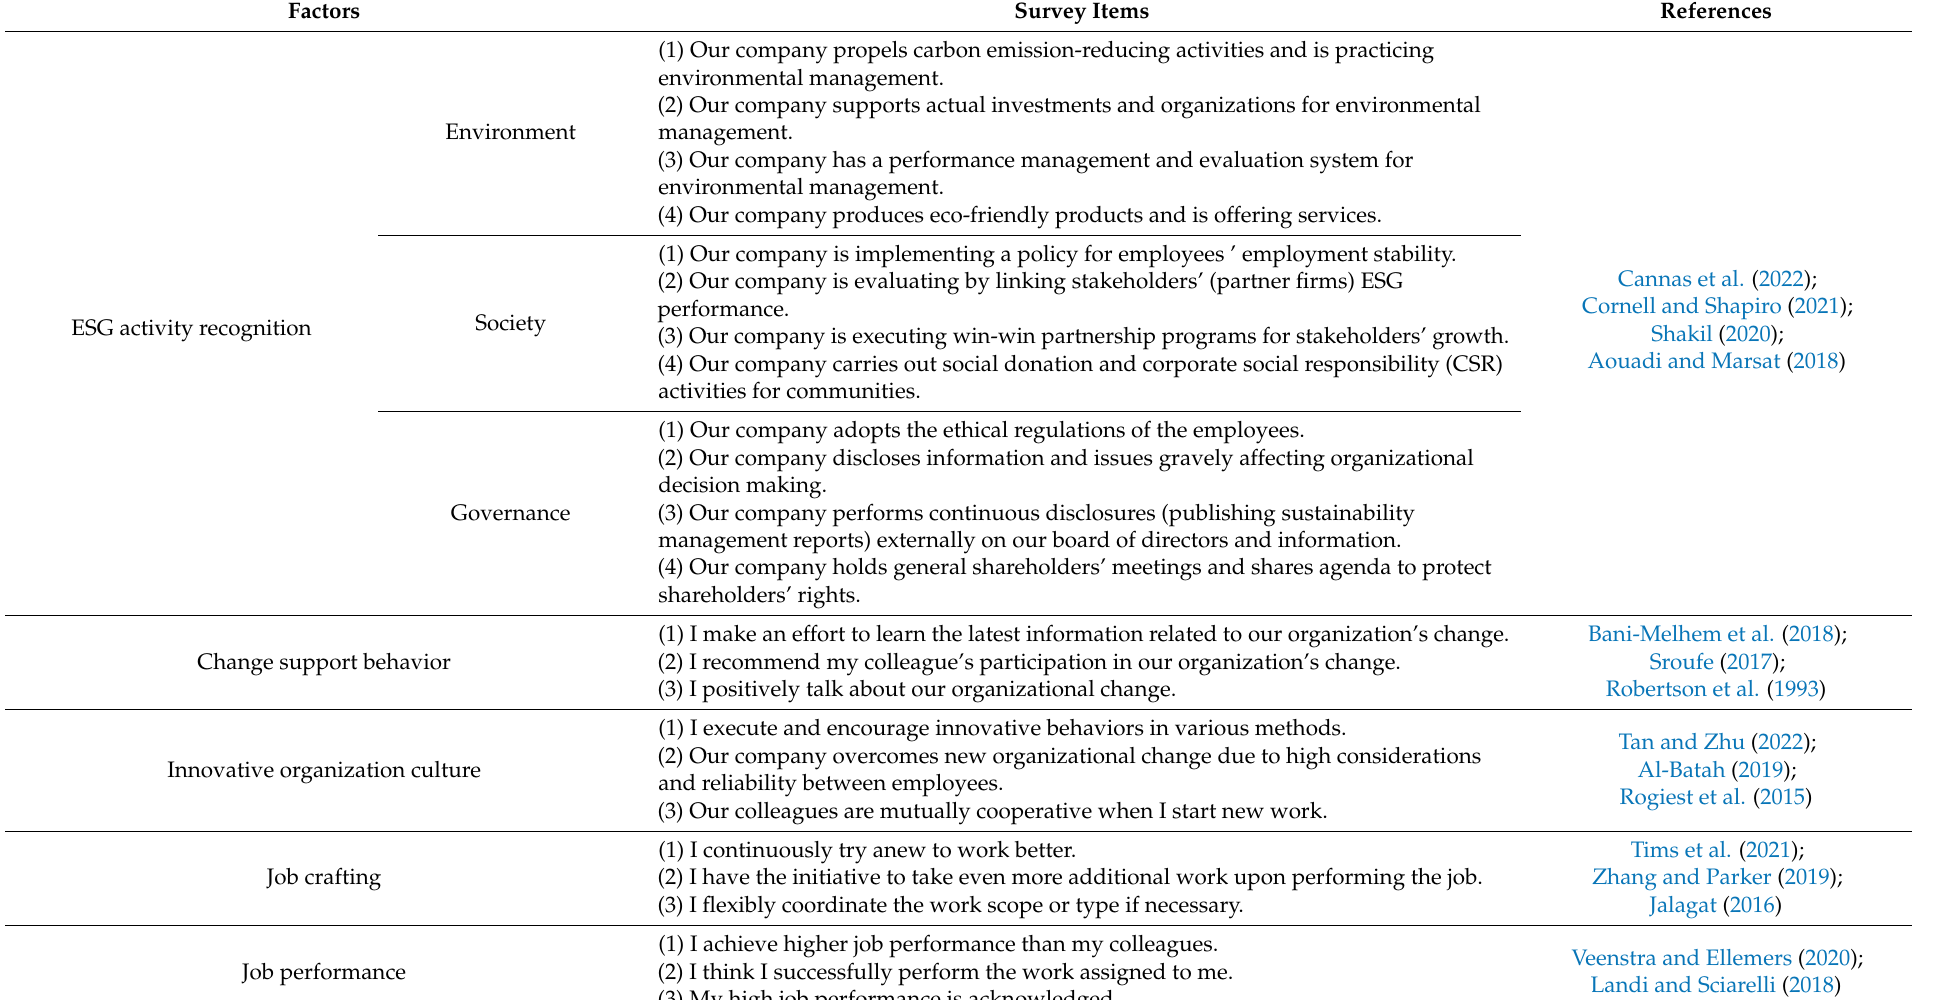
Table 2. Variable definitions and measurement